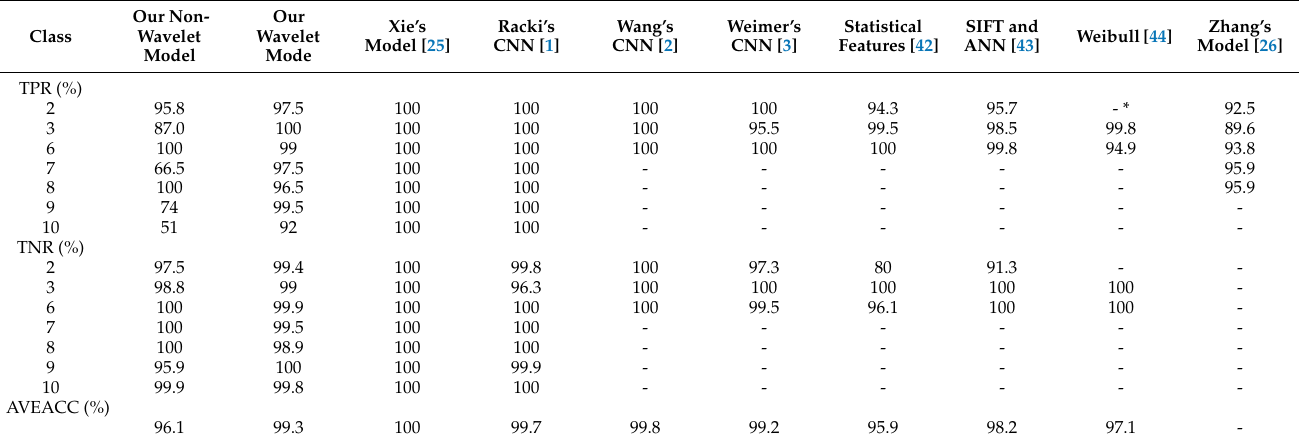
Table 3. The results of our methods in the DAGM2007 dataset and the comparison of others. Here, TPR and TNR are recorded by adjusting the threshold of the judgment strategy to make the acc